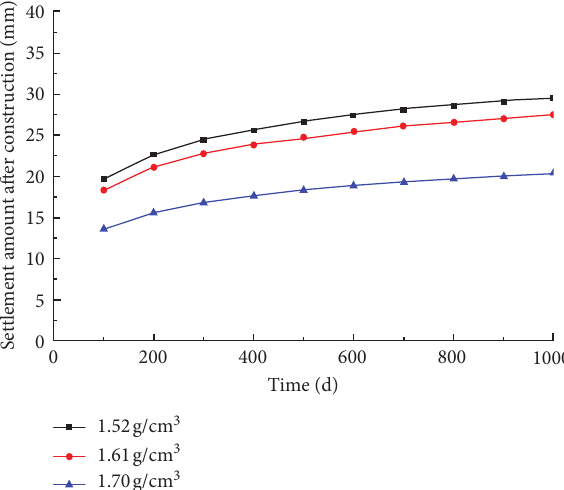
Figure 14: The calculation results of creep deformation under different dry density